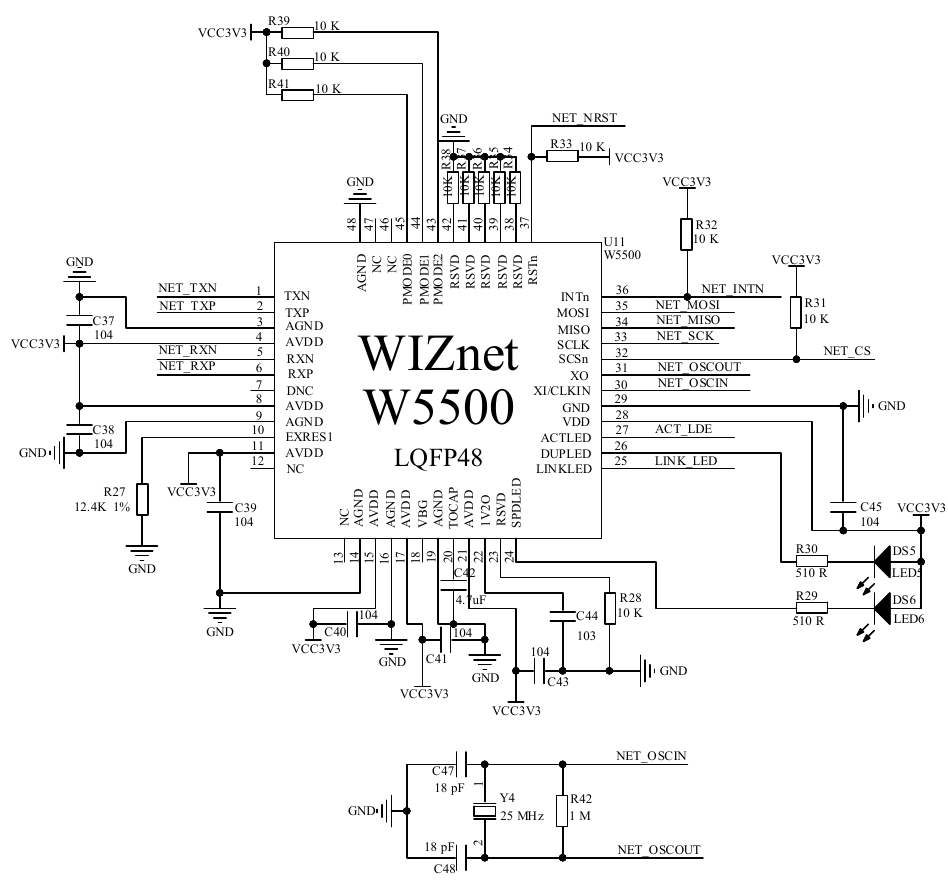
Figure 9. RJ45 communication circuit.